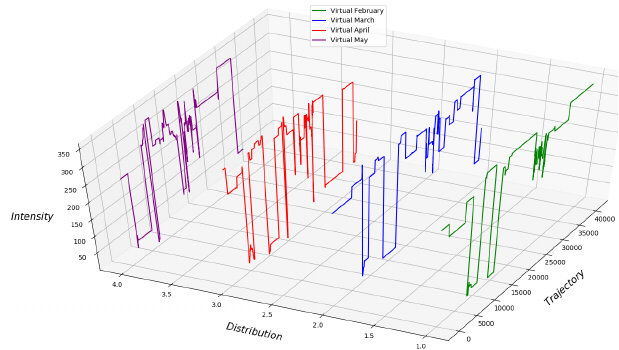
Figure 12. Virtual probable light signatures for trajectory (I) ≥ 0 . 7 Timis oara to Deva with SL=30 and ρ k , With changing baseline between distributions light shapes are represented in figure 12 By selecting a di ff erent trajectory configuration between highway A1 and the DN1 roads, the specific light signature changes accordingly and is represented in figure 13.